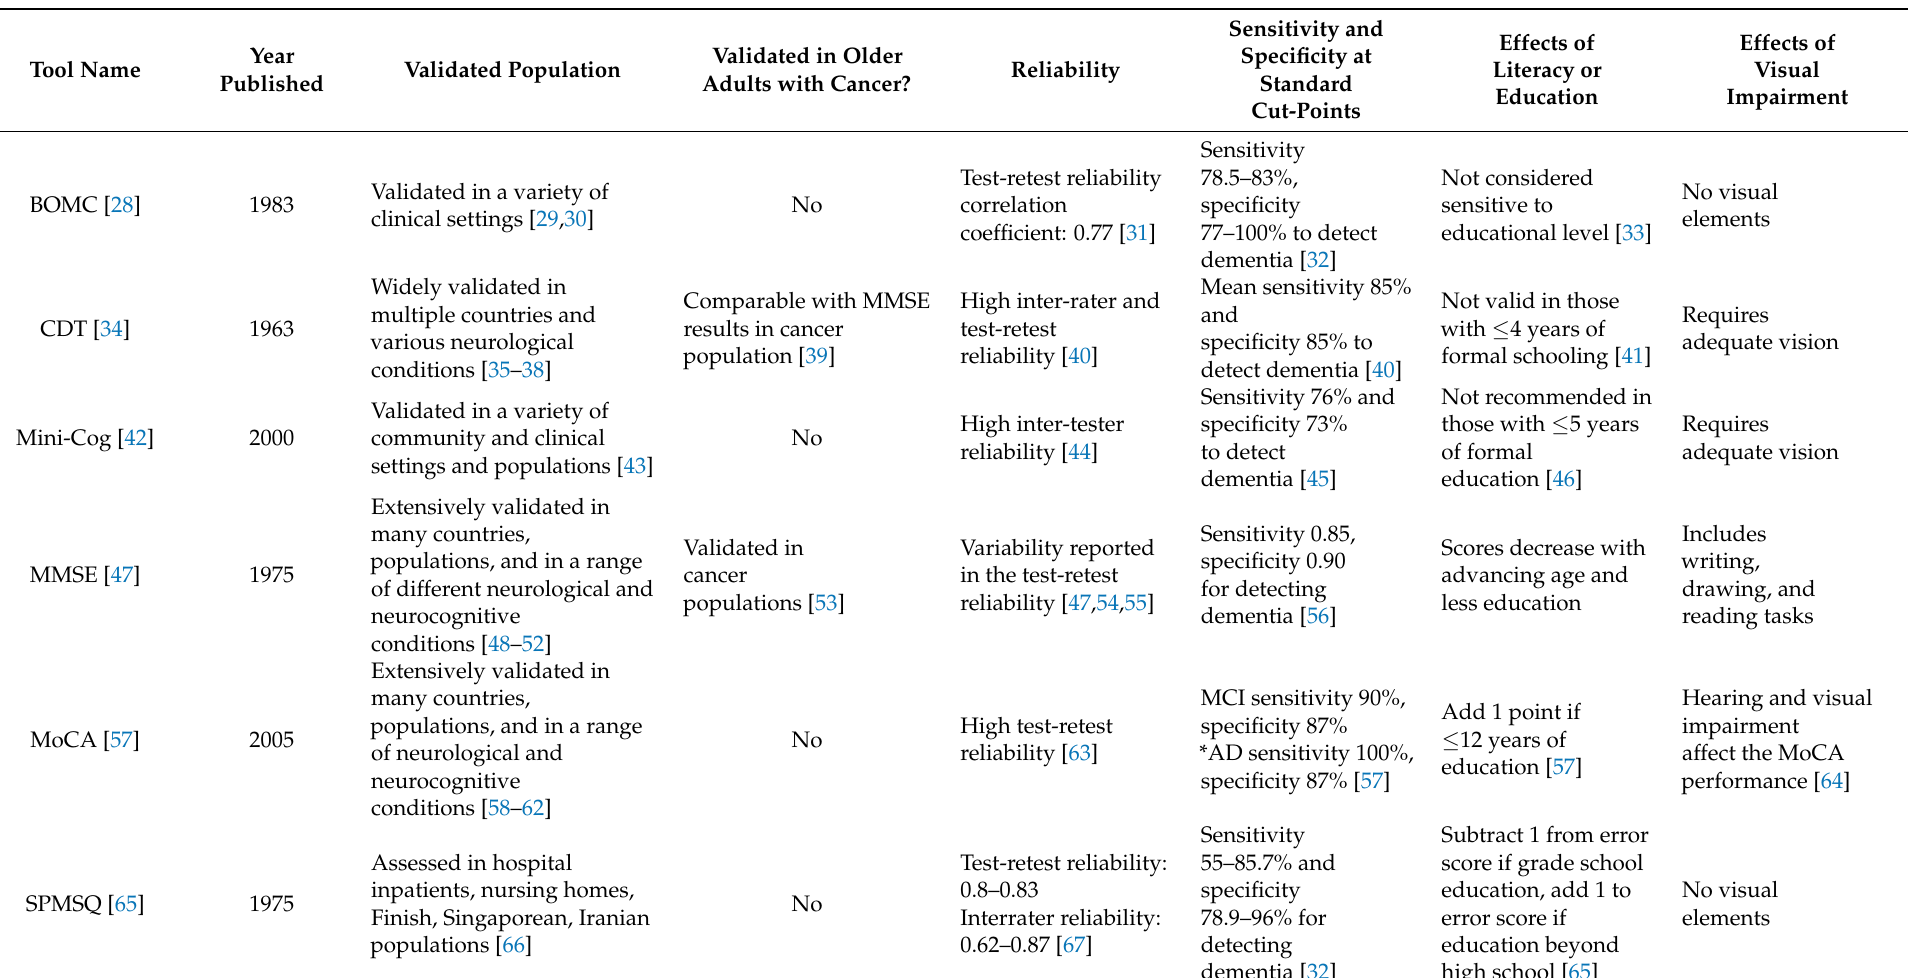
Table 4. Psychometric considerations for clinical